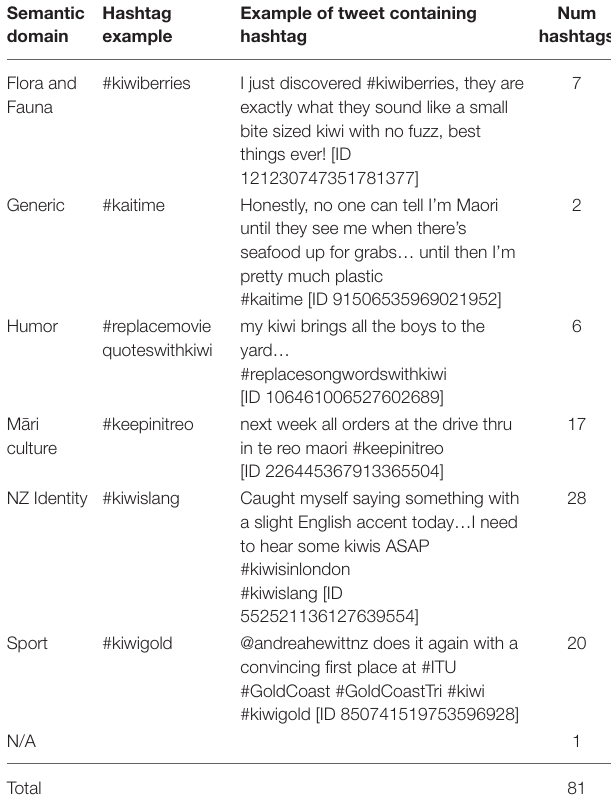
FIGURE 2 | Distribution across various word-classes in the hybrid hashtag set (CNP, common NP; PNP, proper NP; VP, verb phrase; FMLA, formulaic phrase; CLAUSE, full clause; ADJP, adjective phrase; ADVP, adverb phrase; NA, unsure). TABLE 5 | Semantic domain of the various hybrid hashtags in the HH